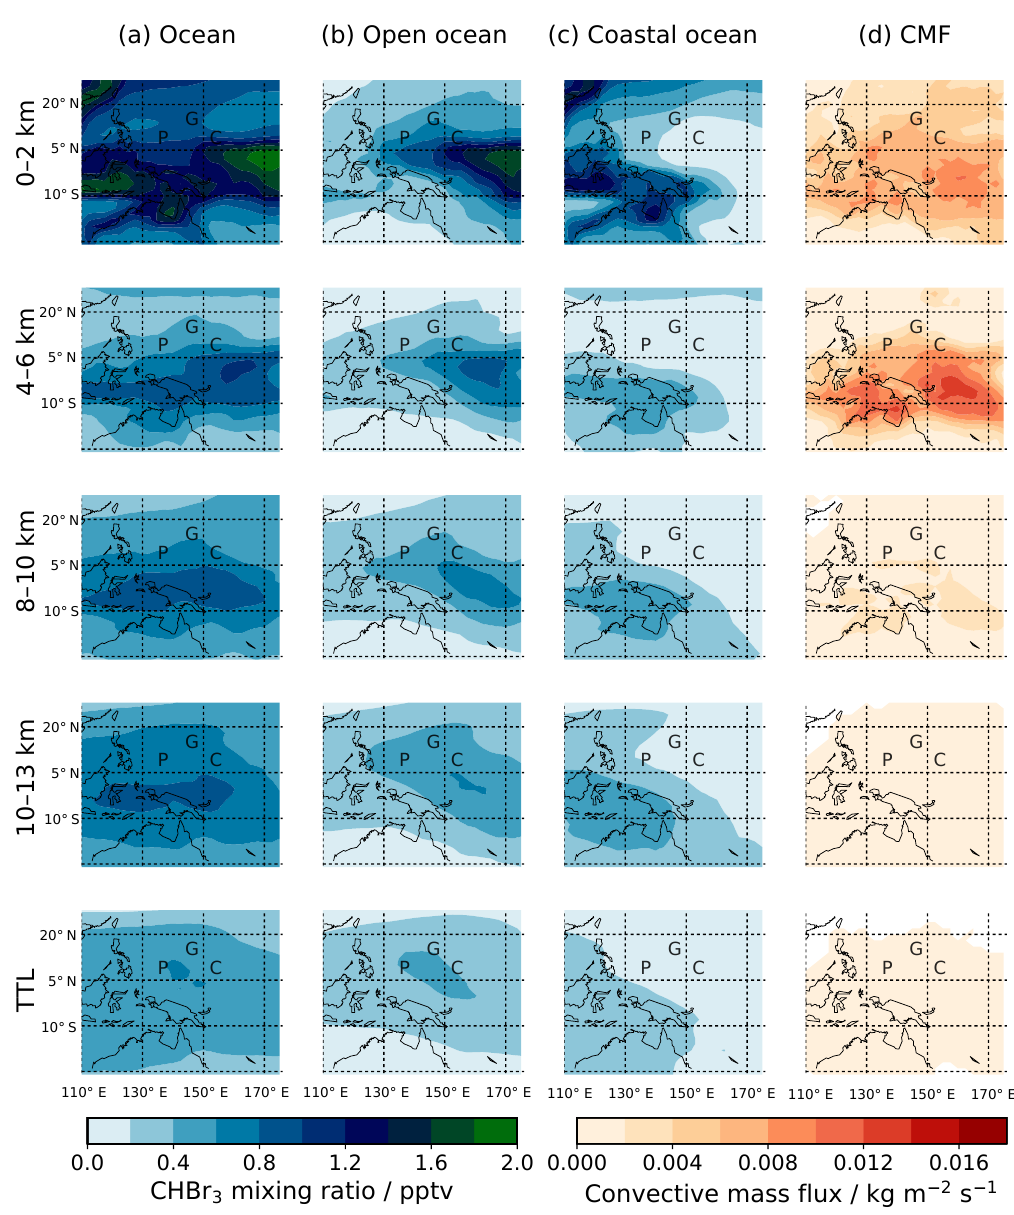
Figure 5. Model mole fractions (pptv) of CHBr 3 over the study domain as a function of altitude, averaged between 18 January 2014 and 28 February 2014, from the total (column 1), open (column 2), and coastal ocean (column 3) tagged tracers. The corresponding mean model convective mass flux (kgm − 2s − 1 ) is shown in column 4. Tagged tracers are averaged from 2h fields and convective mass fluxes are averaged from daily